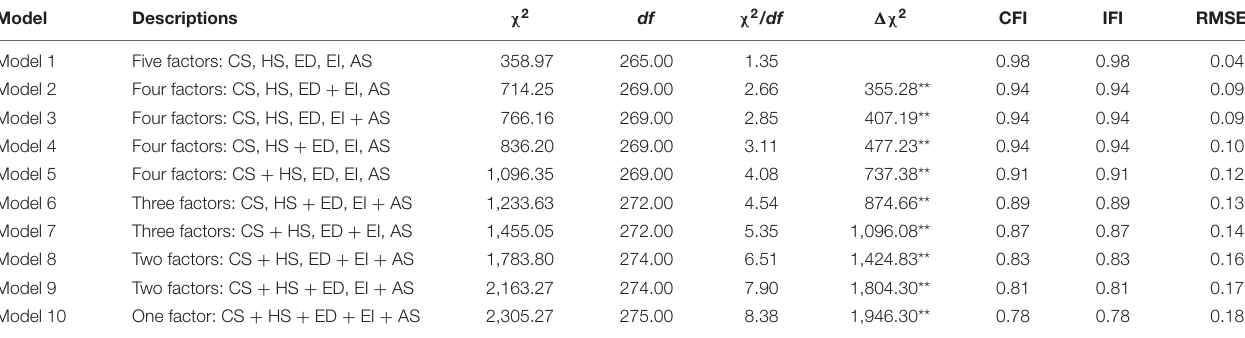
TABLE 1 | Comparison of measurement